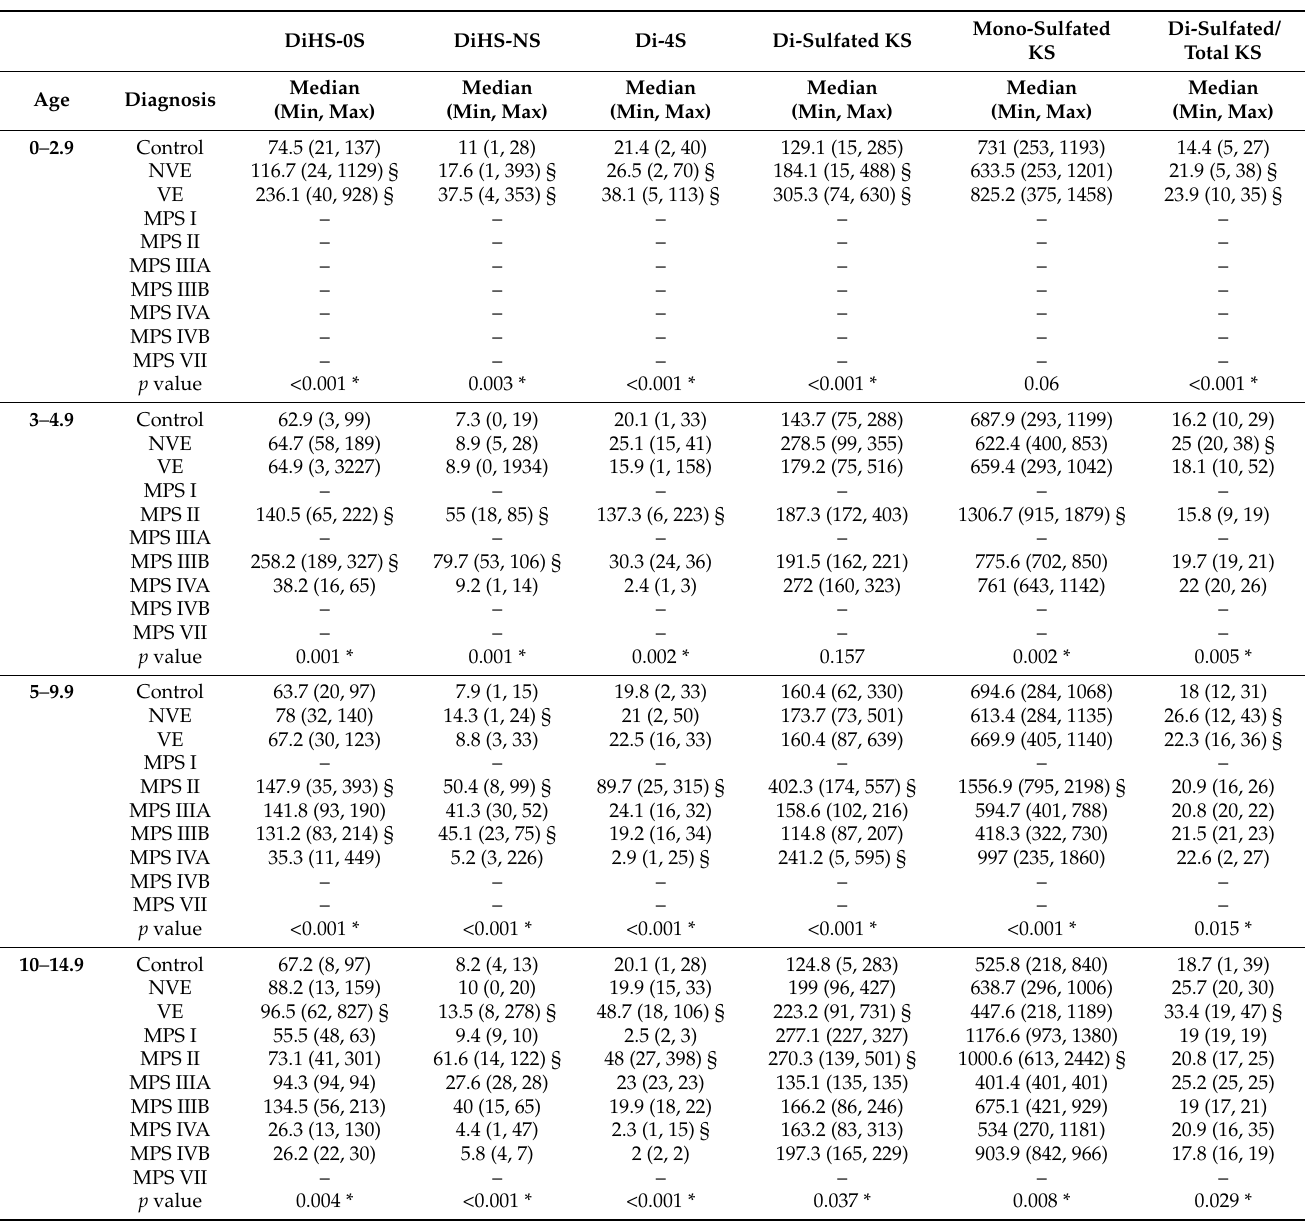
Table 3. Median along with minimum and maximum glycosaminoglycans (GAGs) for control values and patients with viral encephalopathy (VE), non-viral encephalopathy (NVE), or mucopolysaccharidosis (MPS). The p -value for the non- parametric Kruskal–Wallis one-way analysis of variance (ANOVA) test run between the control, encephalopathy, and MPS groups is shown for each GAG at each age group. Statistically significant p -values for the Kruskal–Wallis ANOVA test are marked with an asterisk. Statistical differences between the control and encephalopathy groups or the control and MPS groups were determined with Dunn post-hoc testing and are marked with §. A significance level of 0.05 was used for both